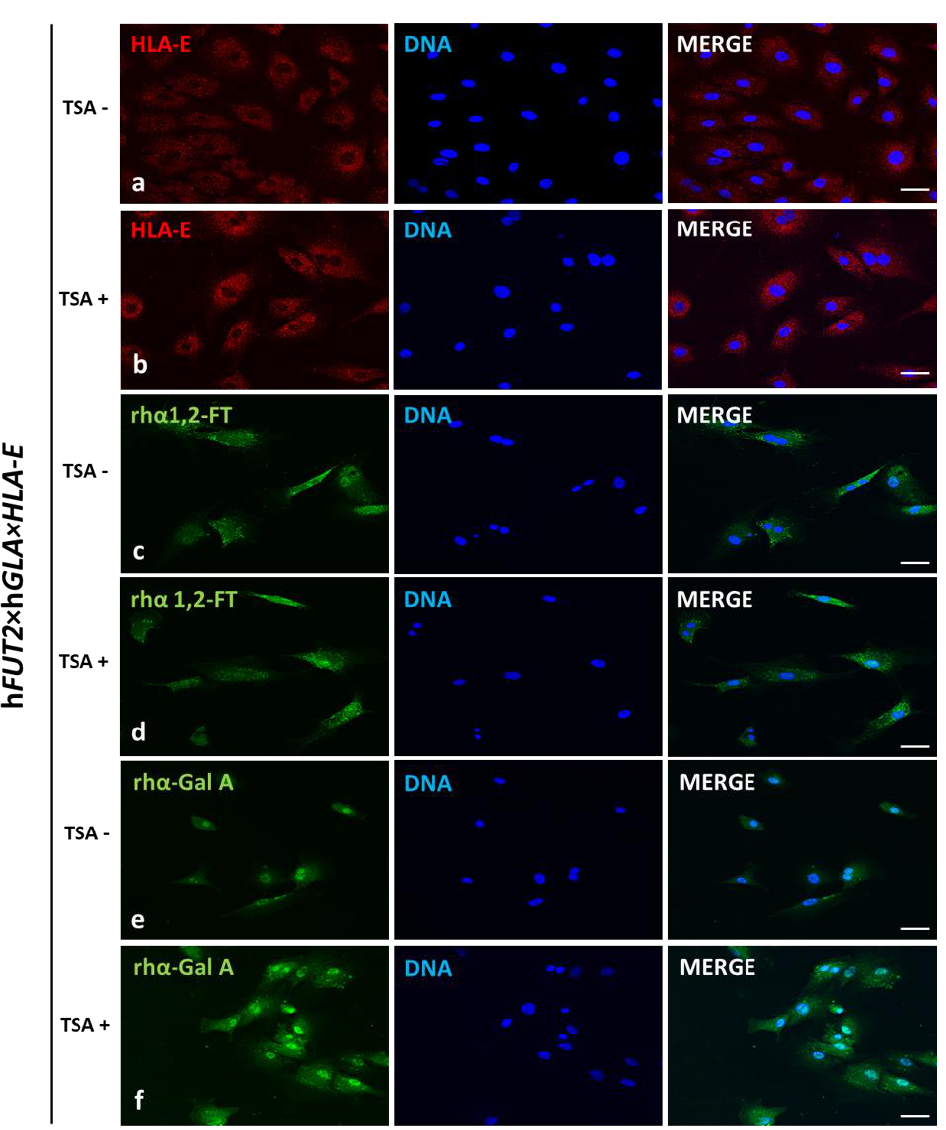
Figure 3. Immunofluorescence analysis of ex vivo-expanded porcine ACFCs epigenomically modulated (TSA+) ( b , d , f ) and not modulated with trichostatin A (TSA − ) ( a , c , e ). Representative microphotographs of immunofluorescence localization of human leukocyte antigen-E (HLA-E; ( a , b )), recombinant human α 1,2-fucosyltransferase (rh α 1,2-FT; ( c , d )) and α -galactosidase A (rh α -Gal A; ( e , f )) in ACFCs originating from h FUT2 × h GLA × HLA-E triple-transgenic pigs. Immunofluorescent staining with Alexa Fluor 488- or Cy3-labelled secondary antibodies (green and red fluorescence, respectively) and DAPI counterstaining (blue fluorescence). Scale bars represent 100 μm. Immunoreaction was performed on ex vivo proliferating porcine ACFCs derived from at least three pigs of each experimental group. The immunofluorescence signal arisen from rh α 1,2-FT was distributed in the perinuclear region of all the analyzed ACFCs from each variant. The MHC representative termed as HLA-E and rh α -Gal A enzyme were homogeneously located in whole cytoplasm of all the analyzed ACFCs. The TSA + ACFCs were characterized by largely intensified signal estimated for both HLA-E and rh α -Gal A proteins ( b , f ), but not for rh α 1,2-FT ( d ) as compared to their TSA − cell counterparts ( a , c , e